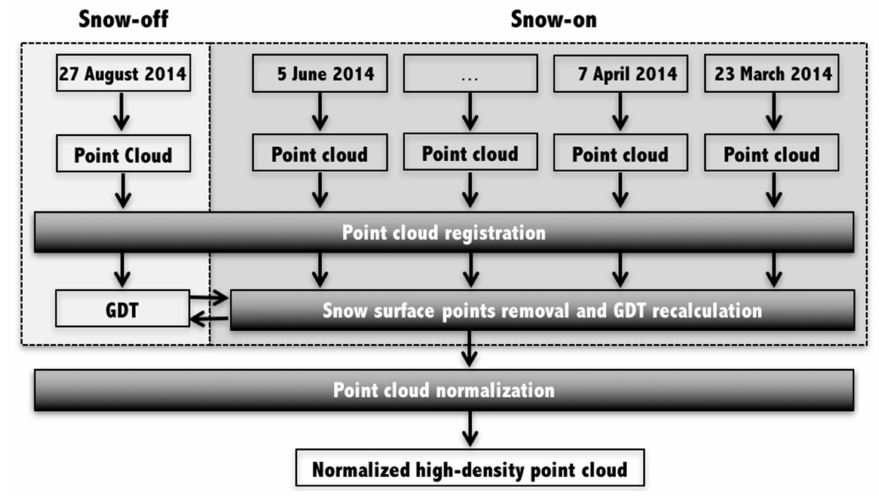
Figure 2. Method workflow to calculate the normalized high-density point cloud from multi-temporal low-resolution data. GDT stand for Ground Delaunay Triangulation. Method steps are represented by the gray